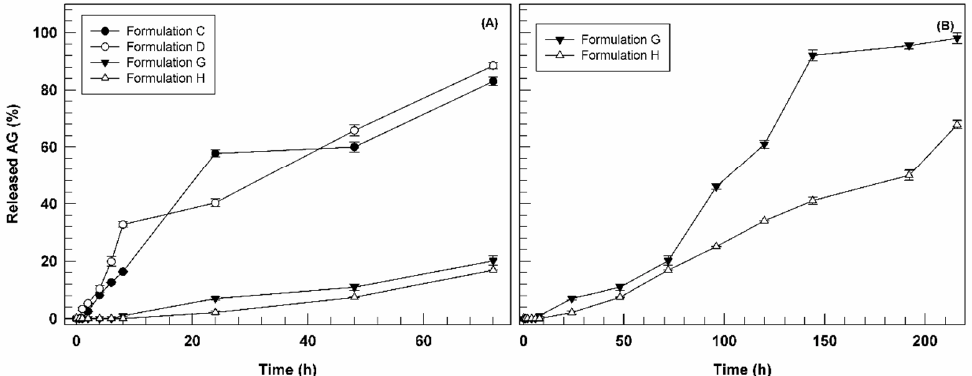
Figure 4. Release profile of AG-loaded ultradeformable nanocarriers as a function of time (Panel ( A ): 0–72 h; Panel ( B ): 0–216 h). Results are the average of five independent experiments ± standard deviation.